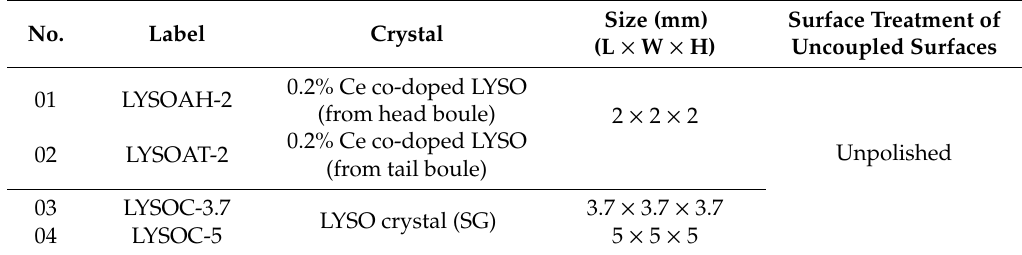
Table 4. Parameters of the LYSO taken from different positions of the crystal boule.